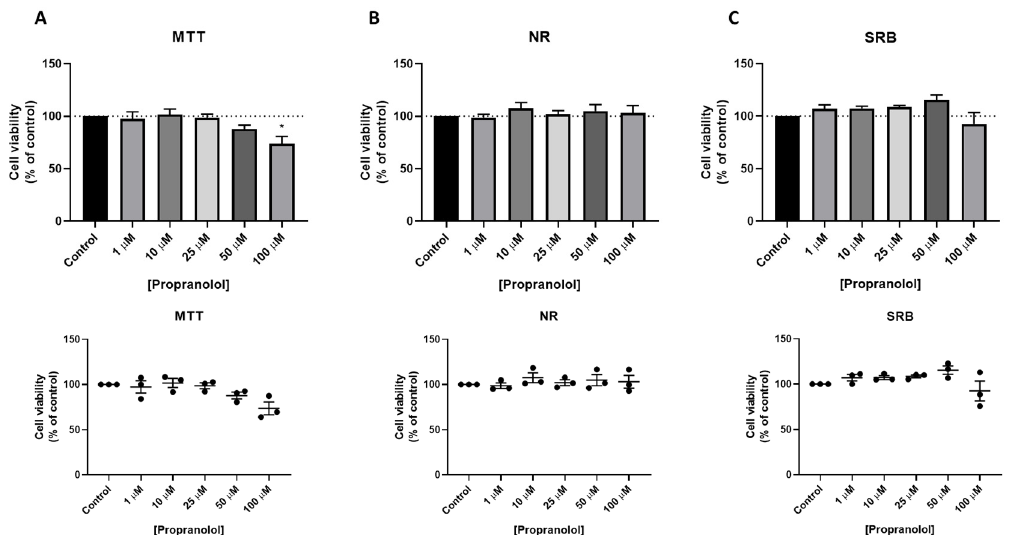
Figure 8. Effects of propranolol on the viability of MCF-7 cells determined by ( A ) MTT, ( B ) NR, and ( C ) SRB assays. Cells were treated with increasing concentrations of propranolol for 24 h. The results are shown as the percentage of control and are expressed as the mean ± SEM of three independent experiments ( n = 3). * Statistically significant vs. control at p < 0.05.